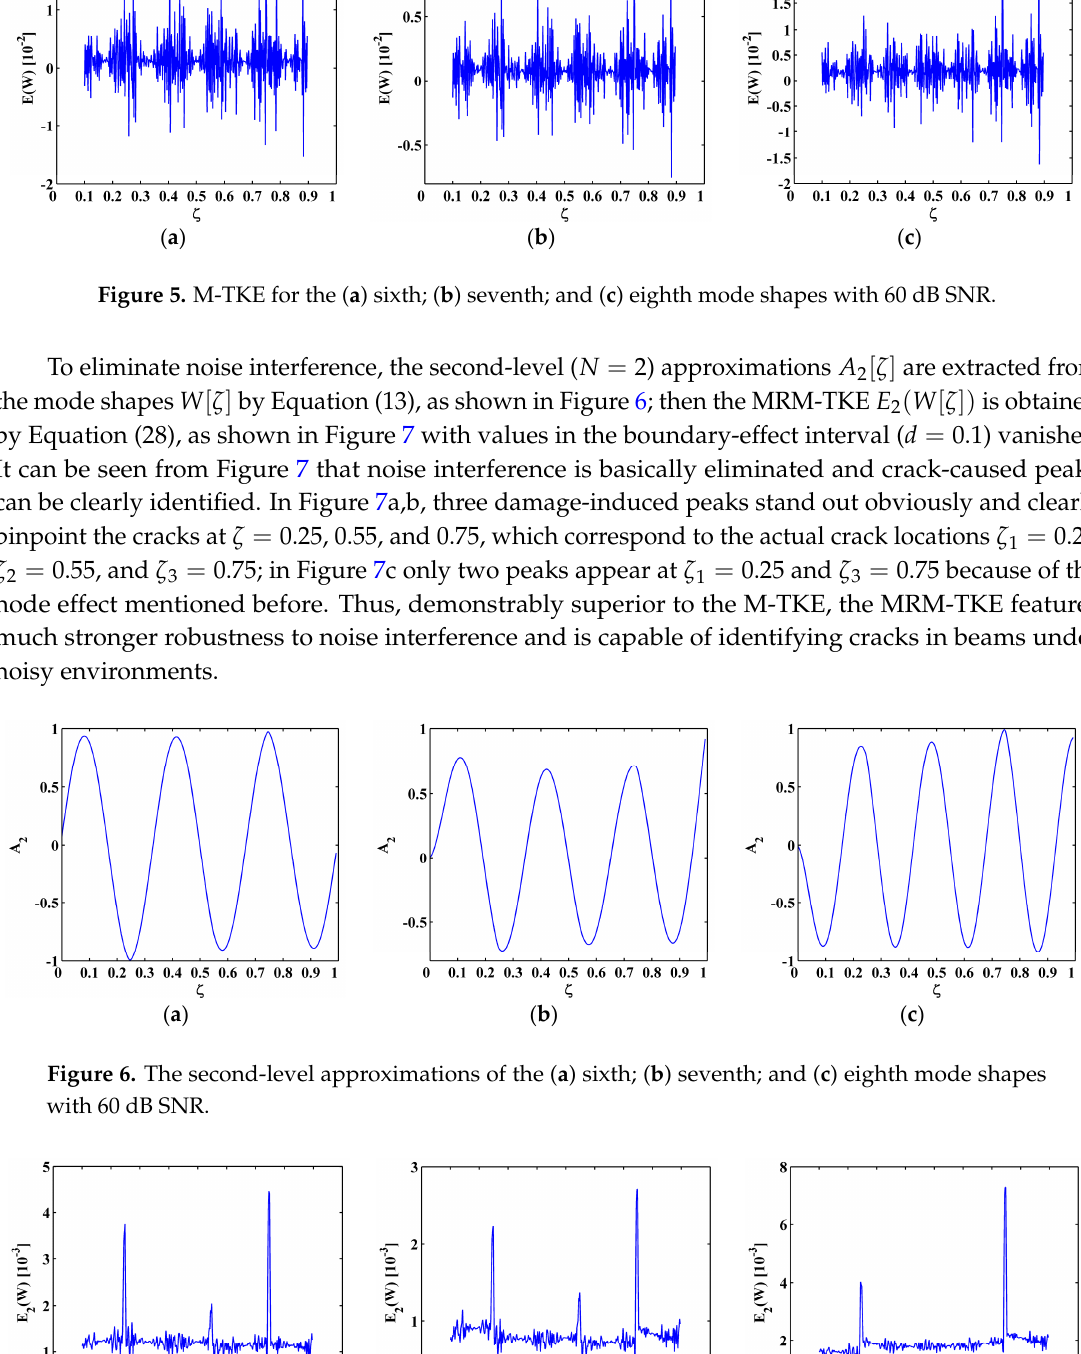
Figure 4. M-TKE for the ( a ) sixth; ( b ) seventh; and ( c ) eighth noise-free mode shapes.